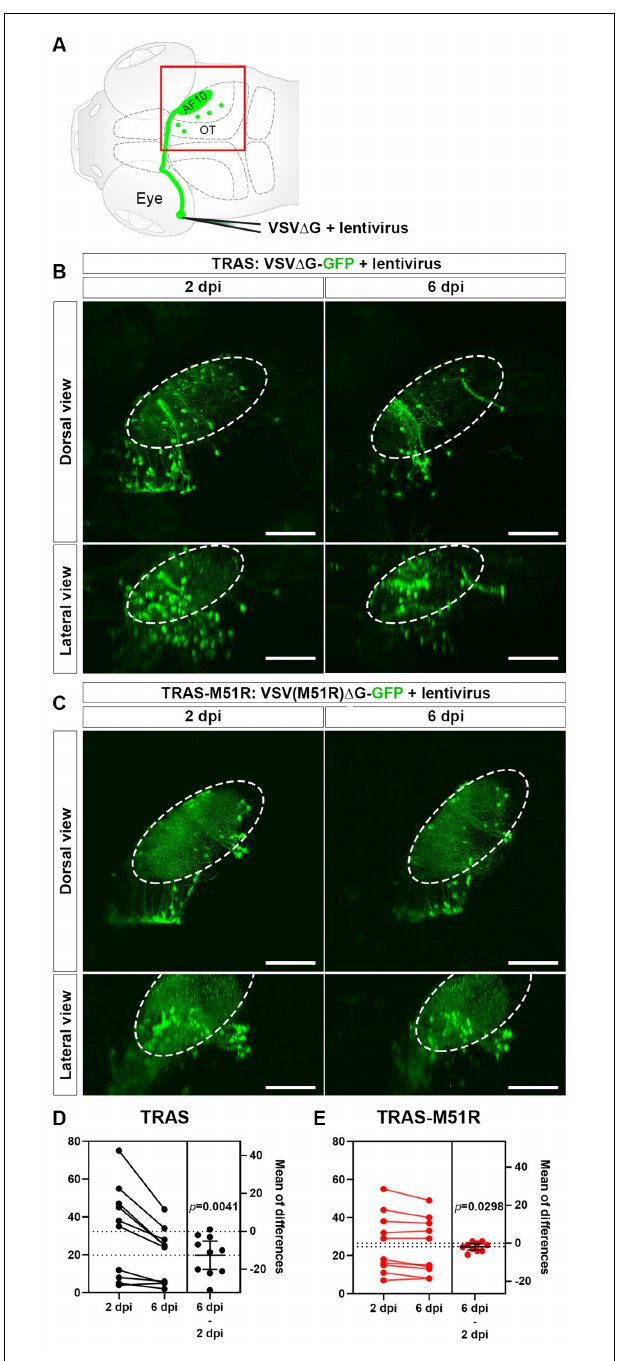
FIGURE 1 | Comparison of VSV ∆ G and VSV(M51R) ∆ G for TRAS labeling. (A) Schematic of TRAS labeling. G-deleted VSV (VSV ∆ G) and VSV-G pseudotyped lentivirus were co-injected into the temporal retina. This results in VSV infection and reporter gene expression in the RGCs in the retina and subsequent transsynaptic spread to retinorecipient cells in the contralateral brain (green circles). The red boxed area is shown in panels (B,C) . OT: optic tectum. AF10: RGC arborization field (AF) 10. (B) TRAS labeling with wild-type VSV ∆ G-GFP. The same animals were imaged at 2 and 6 days post-infection (dpi) [5 and 9 days post fertilization (dpf)], as indicated. Dorsal views are shown in the top row, and lateral